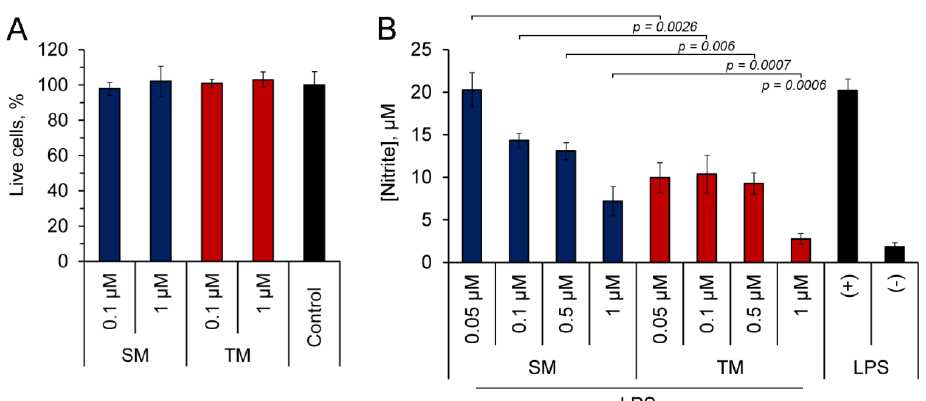
Figure 2. TM effectively inhibited the production of on nitric oxide (II) (NO) by lipopolysaccharide (LPS)-challenged J774 macrophages. ( A ) The viability of J774 cells incubated with or without (control) soloxolone methyl (SM) and trioxolone methyl (TM) for 24 h. ( B ) The effect of triterpenoids on NO production by LPS-activated J774 cells. J774 cells were co-treated by LPS (10 µg/mL) and TM or SM (0.05–1 µM) for 24 h followed by the measurement of the nitrite concentration in a culture medium using the Griess reaction. The results are expressed as the means ± SD of three ( A ) and two ( B ) experiments performed in tetra- ( A ) and pentaplicate ( B ).